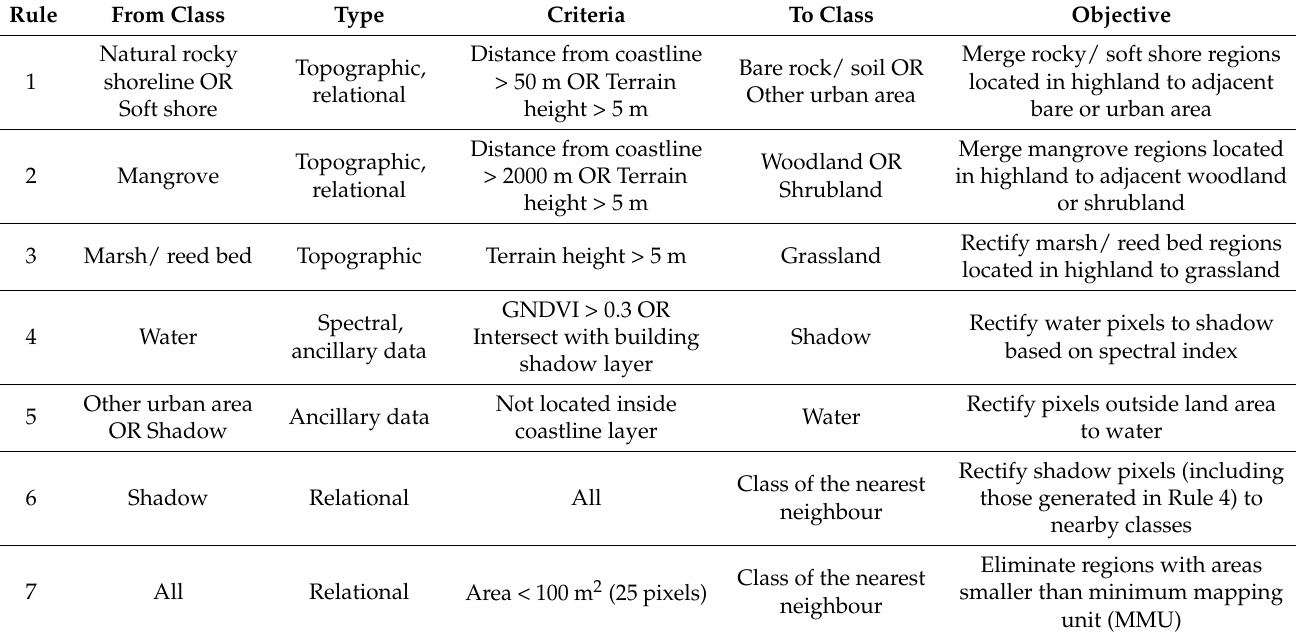
Table 6. Modification rules used in stage 2 to rectify misclassified